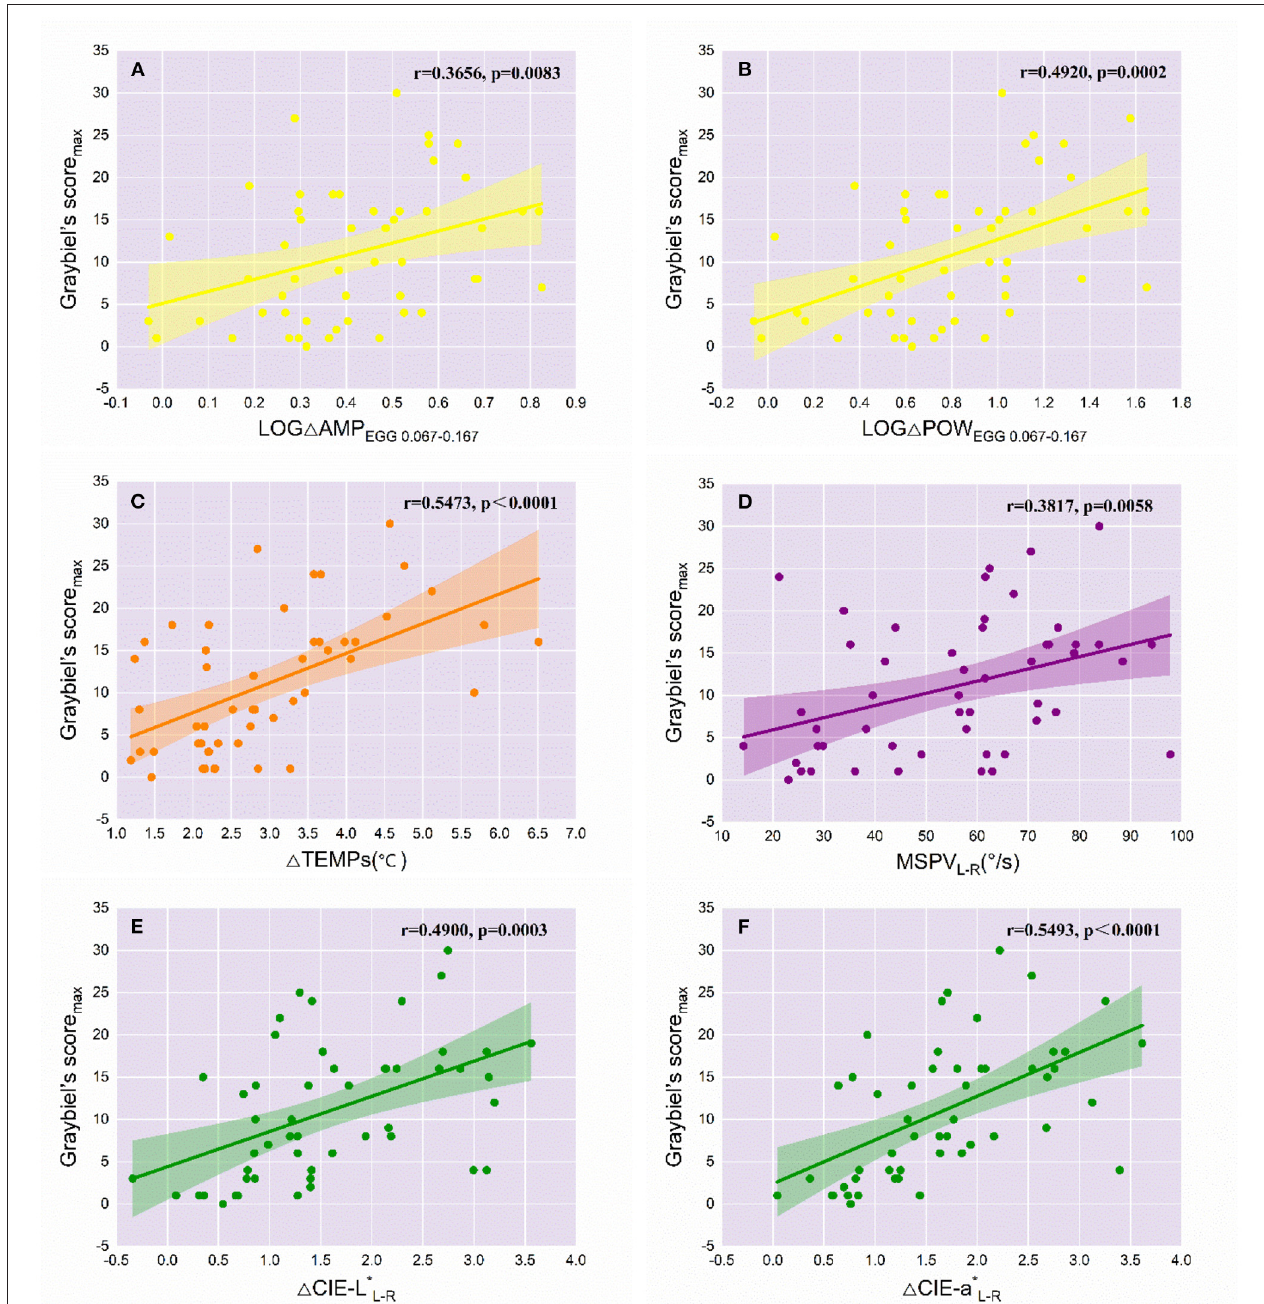
FIGURE 3 | Correlations of the variations of objective indicators with the severity of MS ( n = 51). The r and p values of the objective variables significantly correlated with Graybiel’s score max are labeled in each graph. The colored line represents the line of best fit for each linear regression, while the shaded area indicates the 95% confidence interval. (A) LOG 1 AMP EGG0.067 − 0.167 ; (B) LOG 1 POW EGG0.067 − 0.167 ; (C) 1 TEMPs; (D) MSPV L − R ; (E) 1 CIE-L * L − R ; (F) 1 CIE-a * L − R .